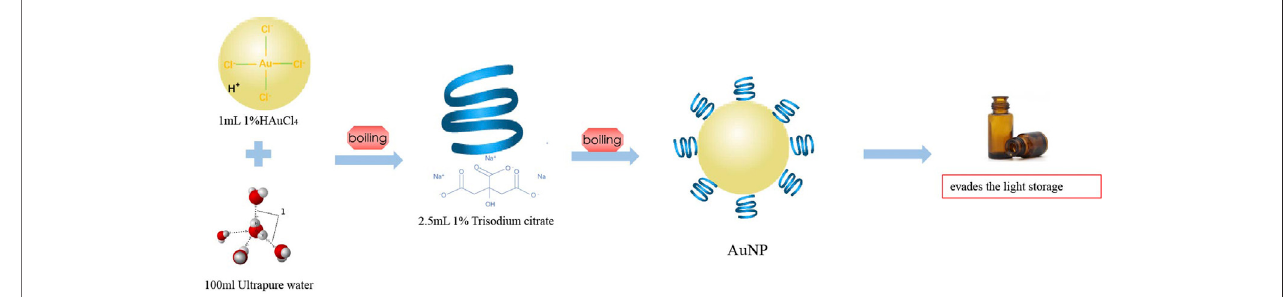
FIGURE 5 | Schematic representation of gold nanoparticle (AuNP)